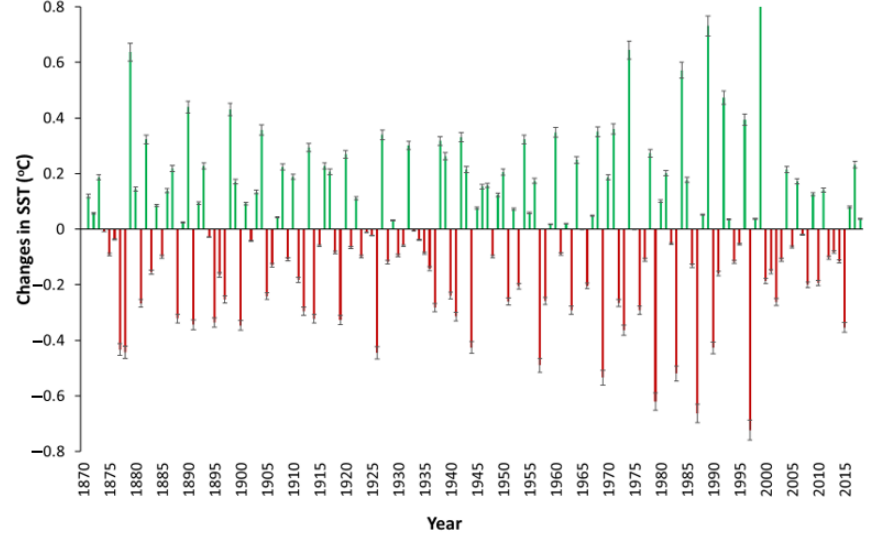
Figure 5. Changes in the mean annual SST in the study area from 1870 to 2018. The black, straight lines indicate the standard error.